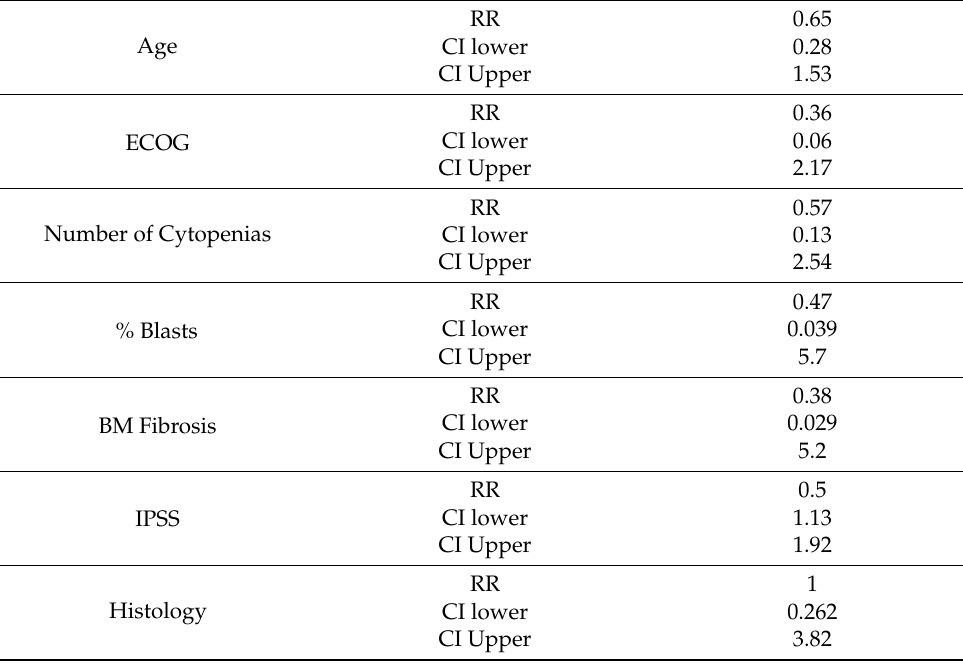
Table 2. Relative risk according to clinical parameters and response to